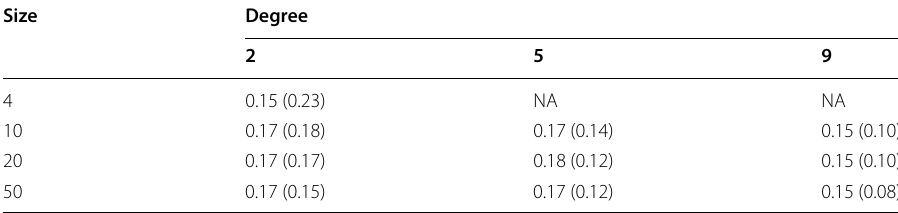
Median and IQR of RMSE for model parameter recovery by degree and network size